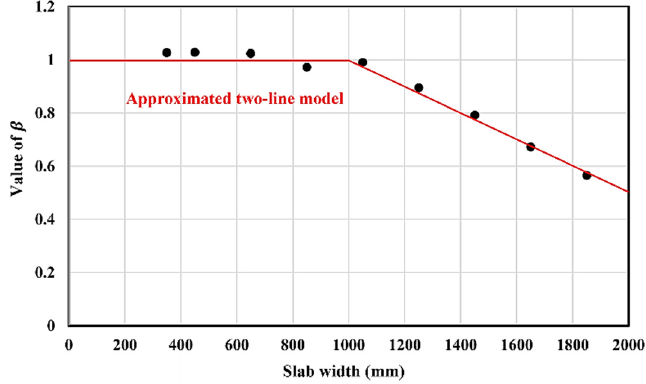
Figure 29. Slab width 𝑏 (cid:3046) -equivalent cross-sectional area ratio 𝛽